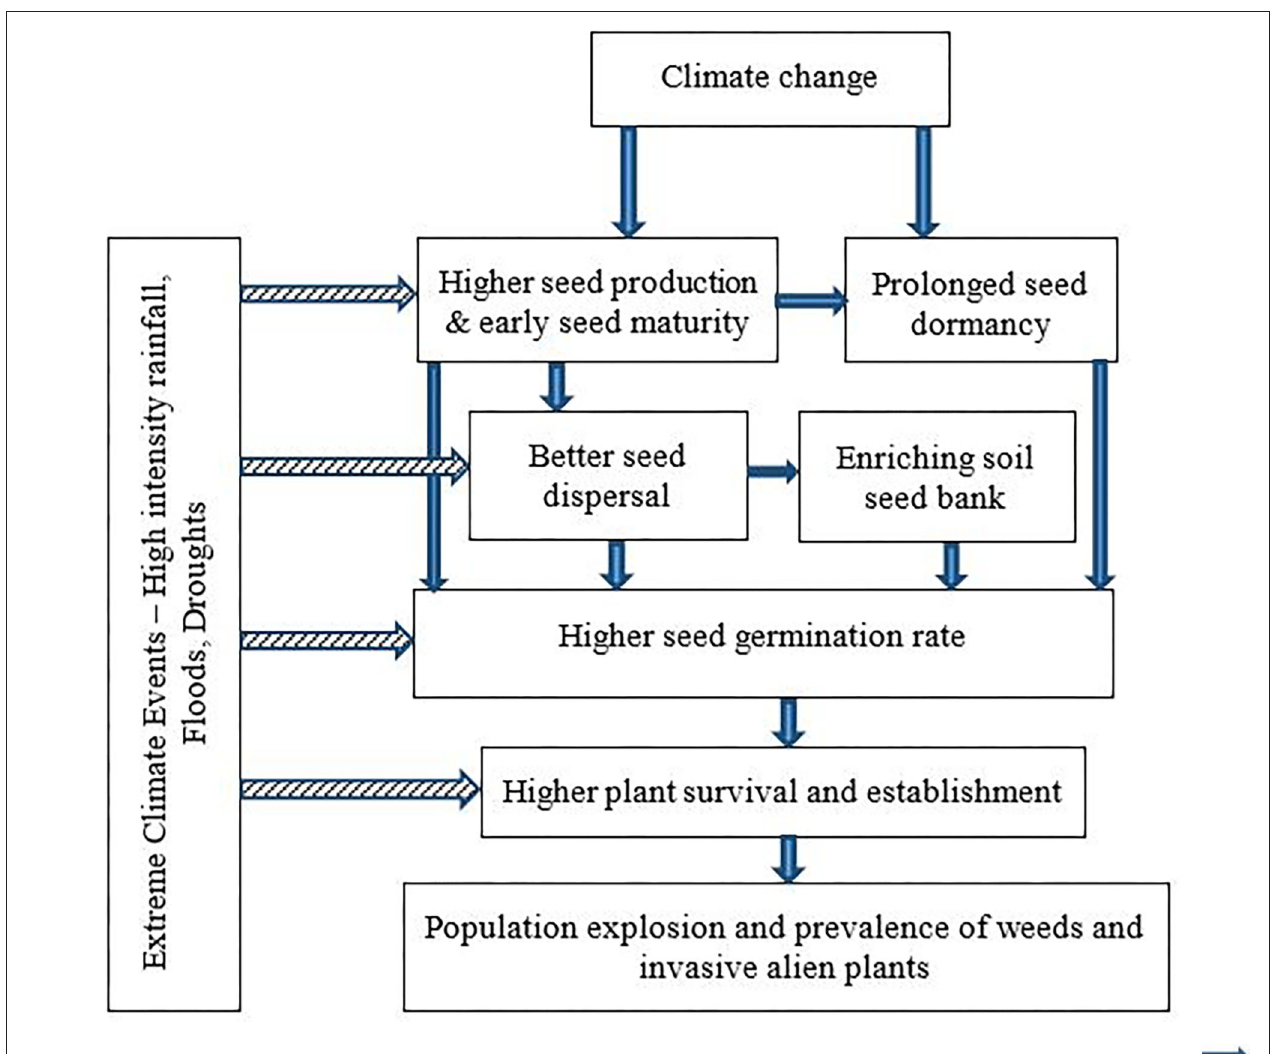
FIGURE 1 | A simplified model depicting only the direct general impacts and specific impacts of climate change on survival of weeds and invasive alien plants Direct general impacts Lower the arrow to align with the center of the text line, Specific impacts of extreme